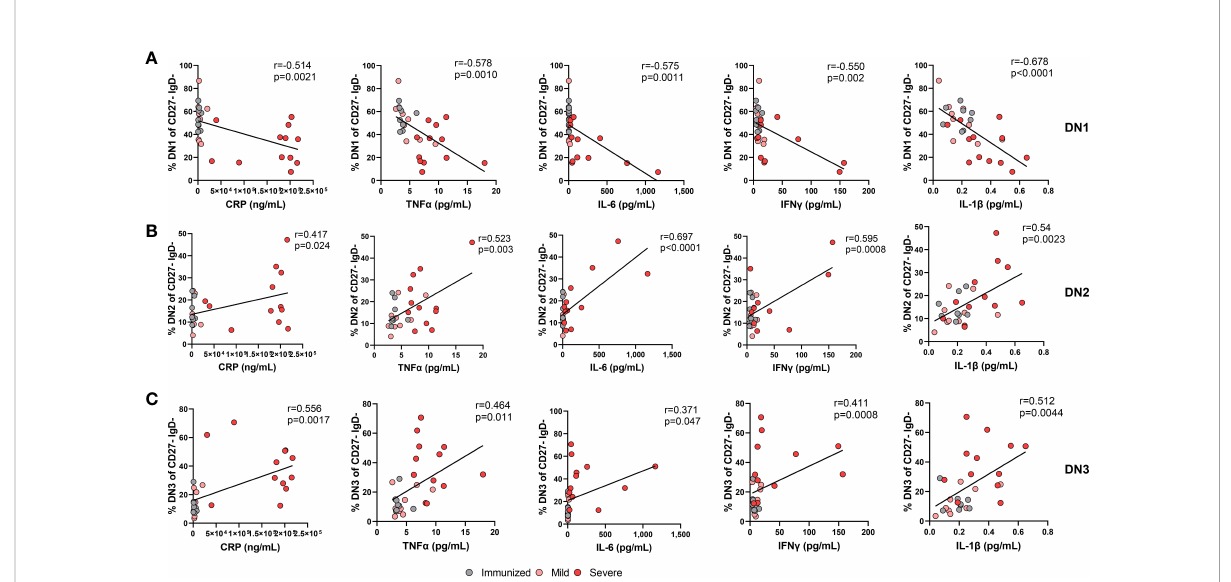
FIGURE 8 The alteration in the frequency of Double Negative populations correlates with increased systemic in fl ammation during Severe SARS-CoV-2 infection. (A) Correlation of systemic cytokine levels (CRP, TNF a , IL-6, IFN g , IL-1 b ) in individuals immunized against SARS-CoV-2 (grey circles, N=8), individuals with mild (pink circle, N=9) and severe SARS-CoV-2 infection (red circle, N=12) with frequency of DN1 cells, (B) frequency of DN2 cells, or (C) frequency of DN3 cells within total double negative population (CD27-IgD-). Statistics: Pearson correlation, r and p values noted on each